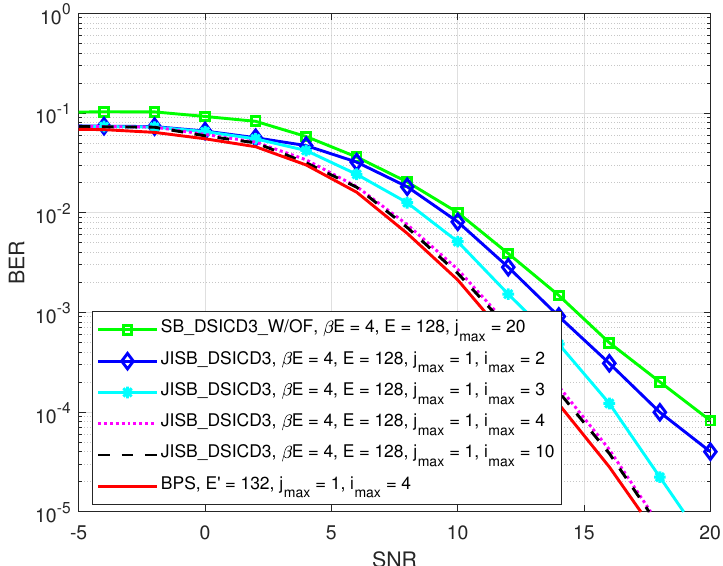
Figure 10. BER versus SNR, p B / σ 2 w for different values of i max ; R = 1/2, p SI / σ 2 w = 30 dB, β E = 4 symbols, and E = 128